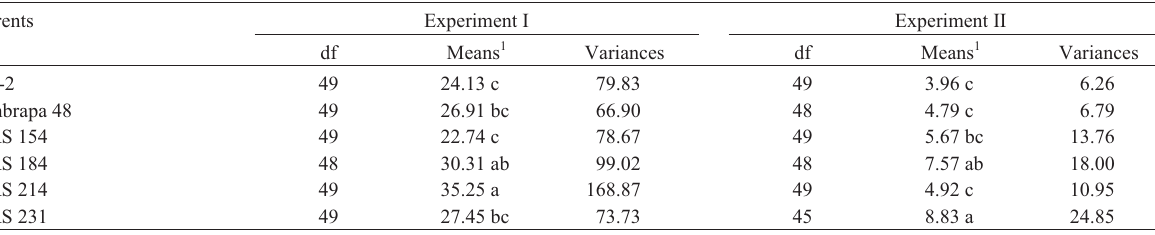
2 and F 3 generations in ex-